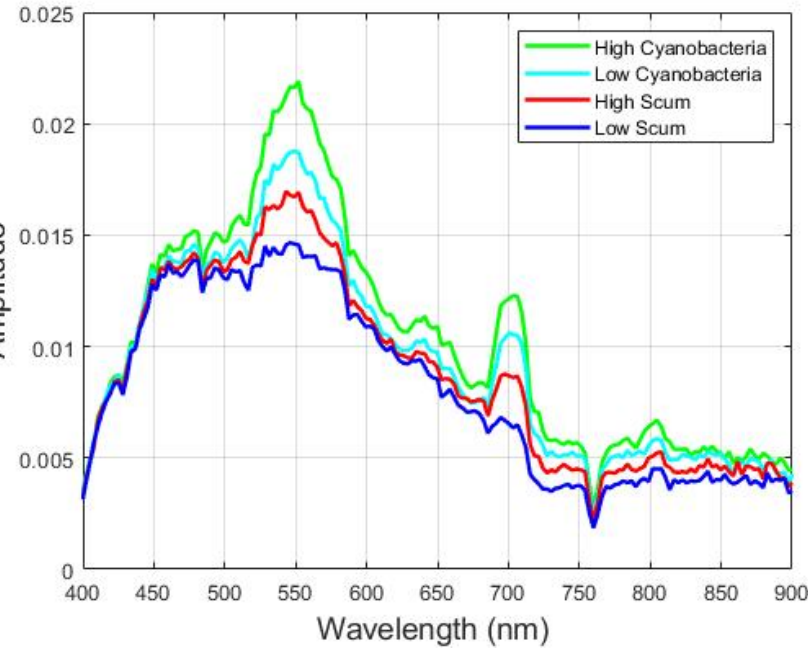
Figure 18. Spectral signature profiles of the CyanoHAB found in the Lake Erie Hyperspectral image.